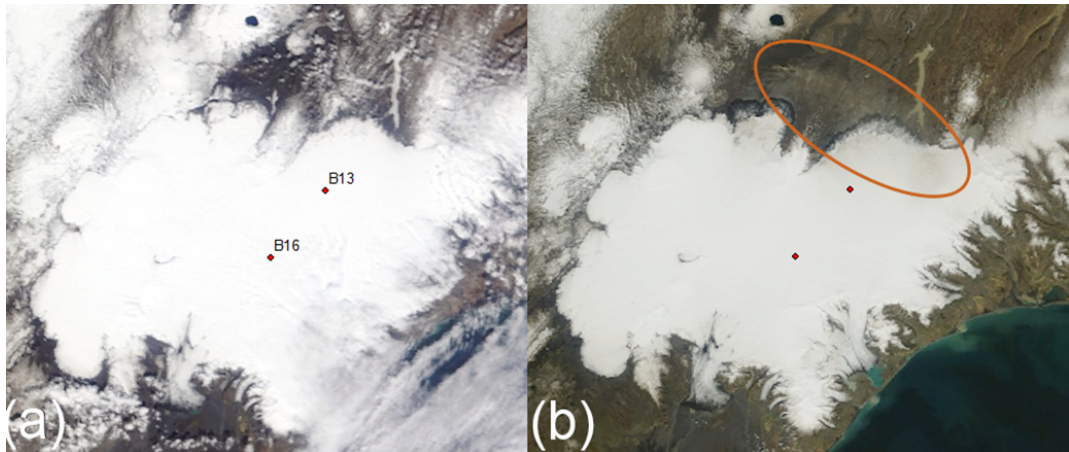
Figure 6. MODIS images of Iceland on (a) 20 May 2012 (day 141) and (b) 28 May 2012 (day 149). Notice the brownish hues (orange circle) on Brúarjökull outlet (northern Vatnajökull) after the dust event, which indicate that dust was deposited on the glacier. Image courtesy of MODIS Rapid Response System at NASA/GSFC.